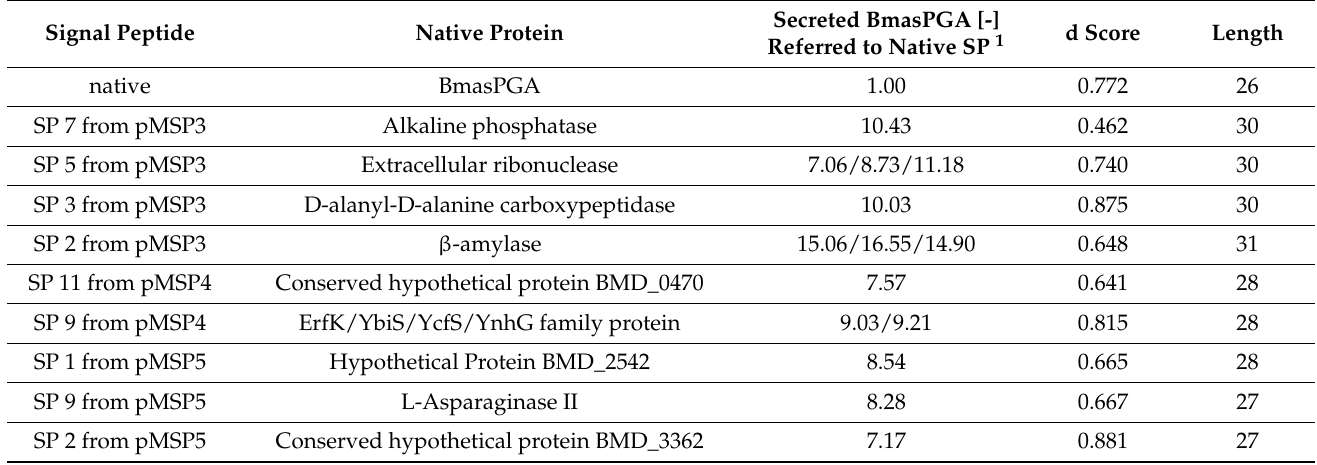
Table 3. Signal peptides achieving a better secretion of BmasPGA compared to the native SP.